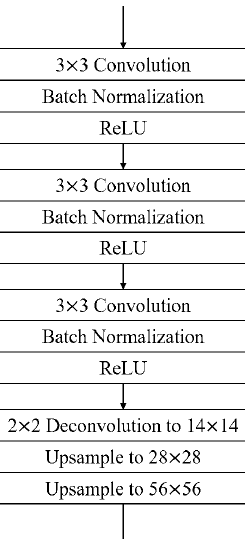
Figure 5. Design of the three-layer CNN.